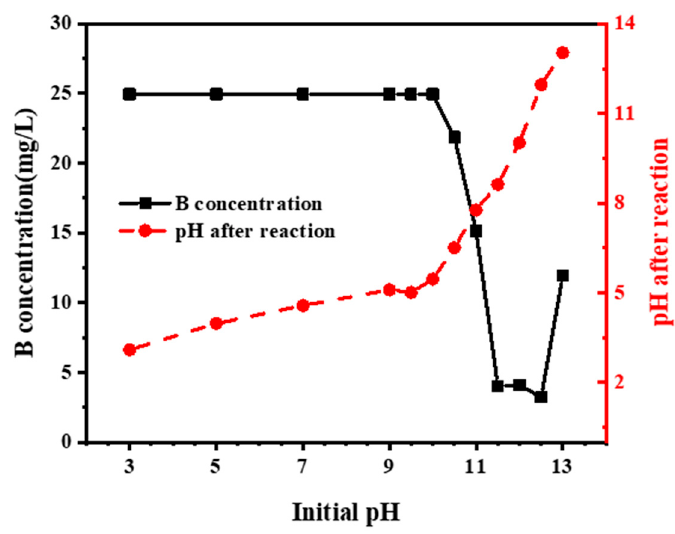
Figure 6. B removal capacity of 61.3 mmol CaCl 2 at different pH.